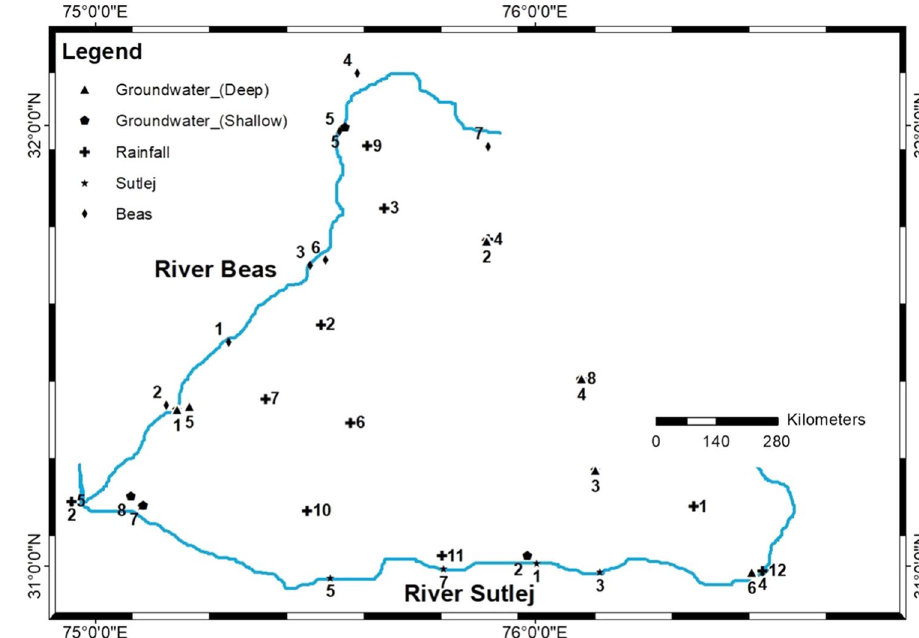
Fig. 5 The water sampling stations of the Bist